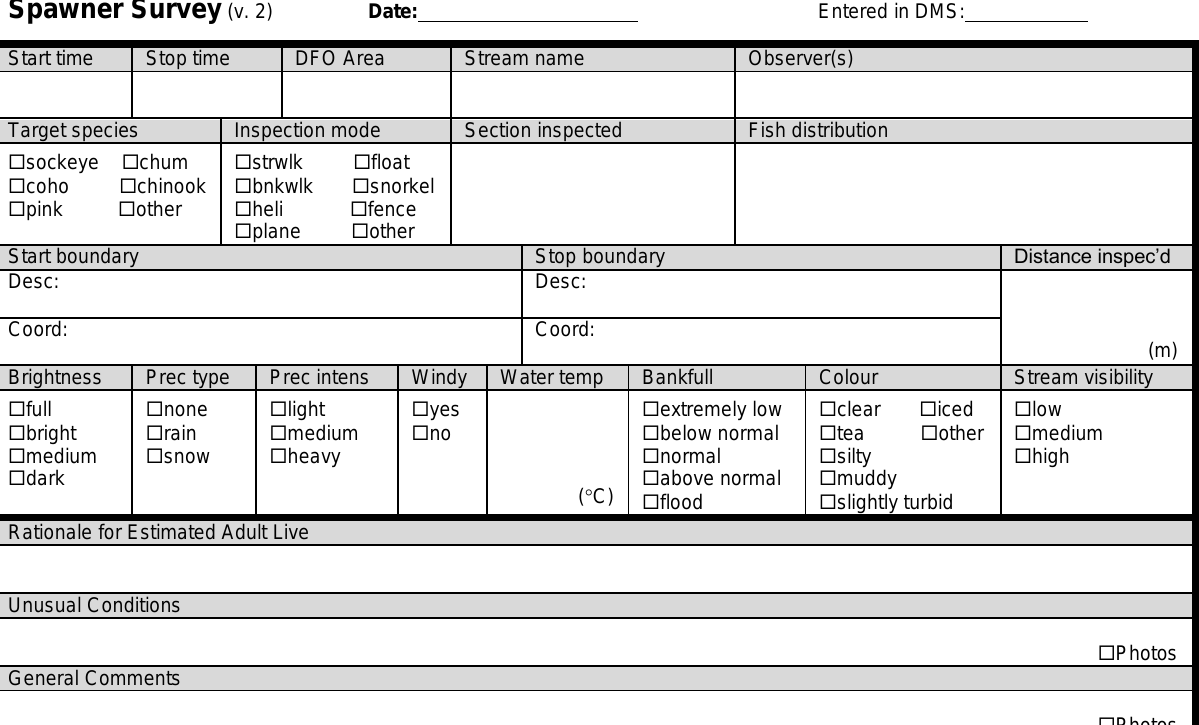
Fig. A1.5 – The Spawner Survey card, which is to be used to collect information on spawning